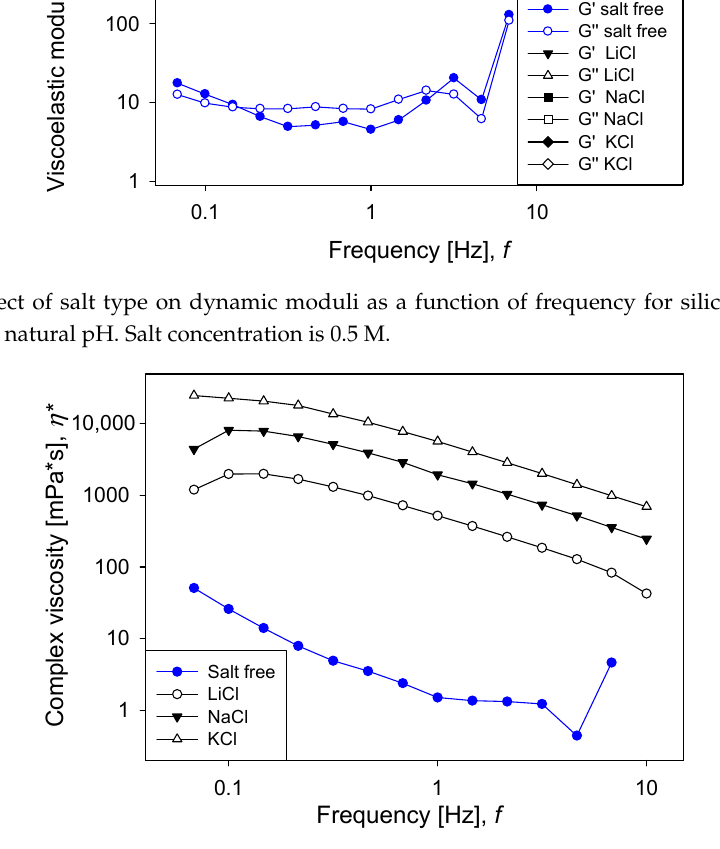
Figure 7. Effect of salt type on complex viscosity as a function of frequency for silica suspensions formulated at natural pH. Salt concentration is 0.5 M.